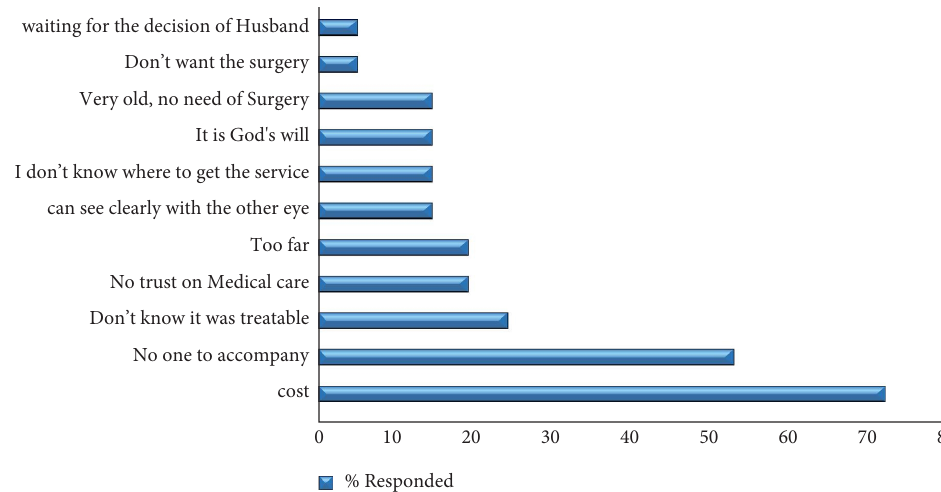
Figure 4: Factors infuencing individuals with cataract from seeking medication in South Ari, Southern Ethiopia, in December 2021. Table 5: Bivariate and multivariable logistic regression analysis of cataract prevalence and factors associated with it in South Ari district, Southern Ethiopia, in December